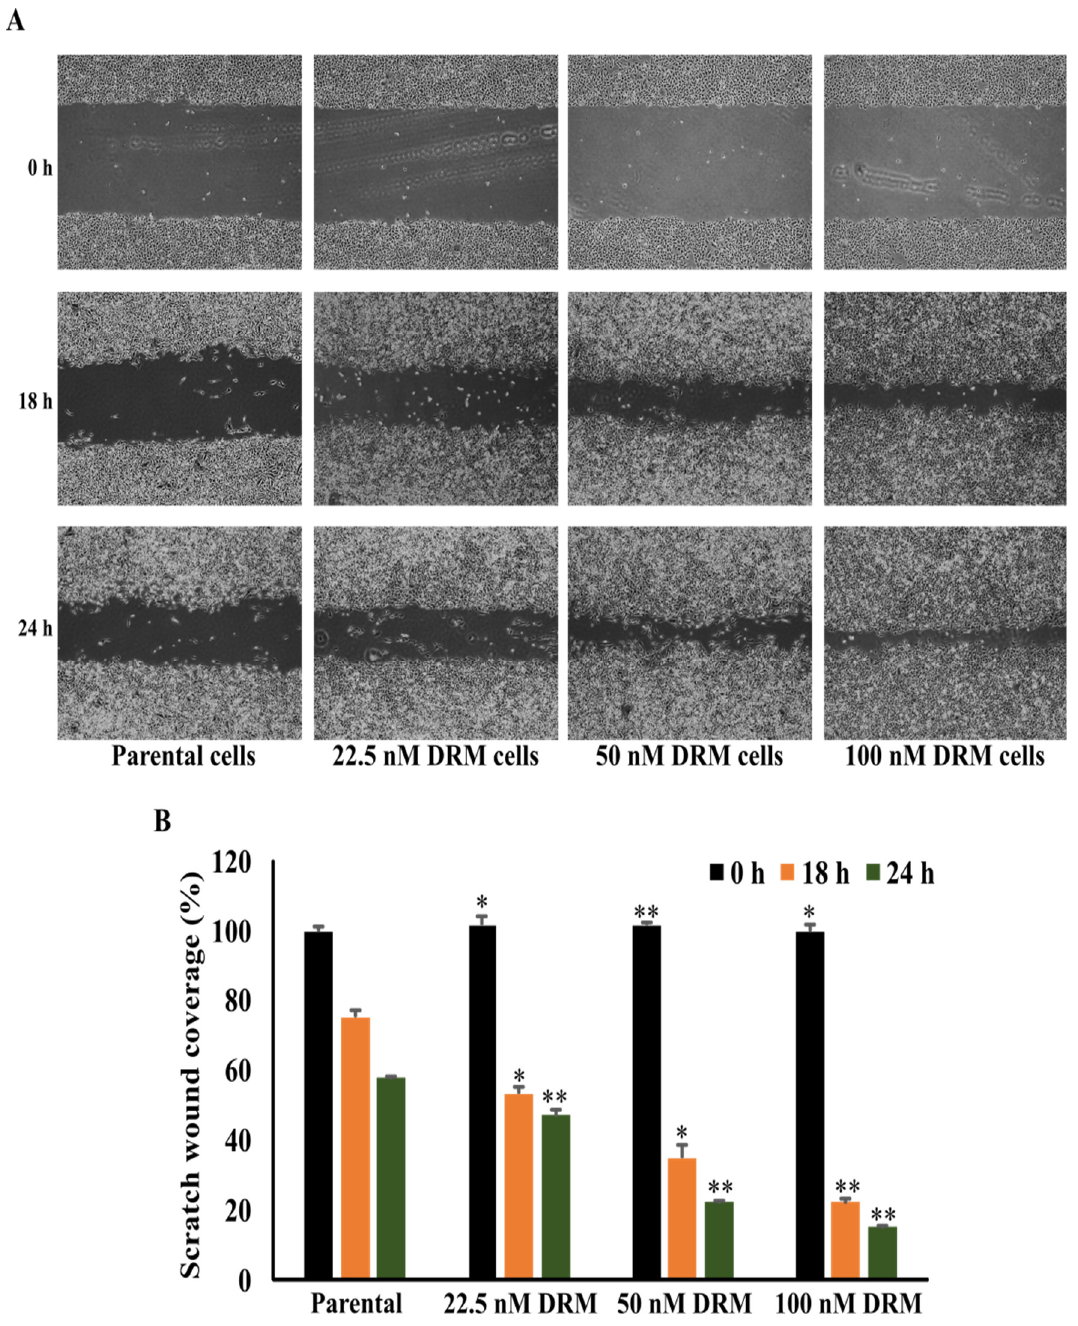
Figure 5. DRM cells have an increased migration potential. The wound healing assay indicated the area of wound closure in 22.5 nM, 50 nM, 100 nM DRM cells, and the parental cells which were 47%, 22%, 15%, and 58%, respectively. The cells were grown with 100% confluence and a wound was created with the use of a 1 mL tip. ( A ) The migratory effect of the cells was analyzed with the photograph of the etched area with the mentioned durations. ( B ) The area of the cell migration was measured with the use of ImageJ software and graphed. The values expressed as mean ± standard deviation (SD) ( n = 5) ((* p < 0.05 vs. prental cells;, ** p < 0.001 vs. parental cells). DRM: Doxorubicin-resistant MDA-MB-231.